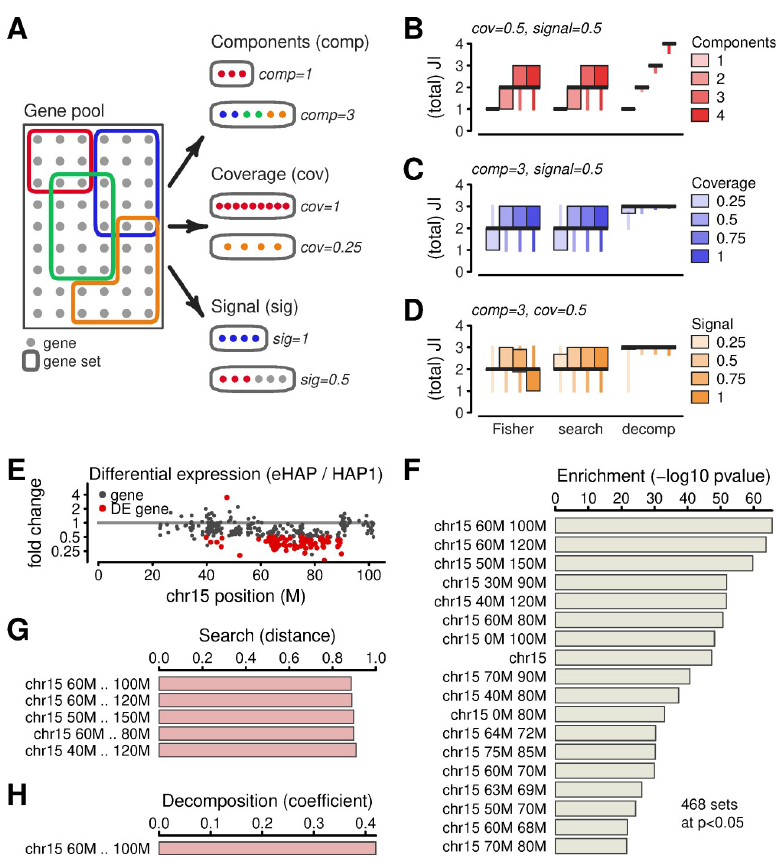
Fig 2. Applications of search and decomposition algorithms on gene sets. (A) Schematic of synthetic gene sets for benchmarking calculations. The gene pool contains all human genes and sets are based on GO annotations. Benchmarking datasets are generated by randomly selecting genes from one or more sets. Generation strategies include components (taking genes from one or more GO set), coverage (taking all genes from a set, or fractions thereof), signal (augmenting genes from GO sets with randomly selected genes). (B-D) Results of benchmarking calculations performed using three computational methods—the Fisher statistical test, and search and decomposition powered by nearest-neighbor searches. Vertical axes show sums of Jaccard Indexes between reported and expected gene sets. This score counts the number of correctly identified components. (E) Visualization of differentially- expressed genes in the eHAP cell line along one of the chromosomes. (F) Output of hypeR gene set enrichment analysis, comparing DE genes with a collection of sets that contain genes from genomic regions of various sizes. (G) Output from gene set search. (H) Output from gene set